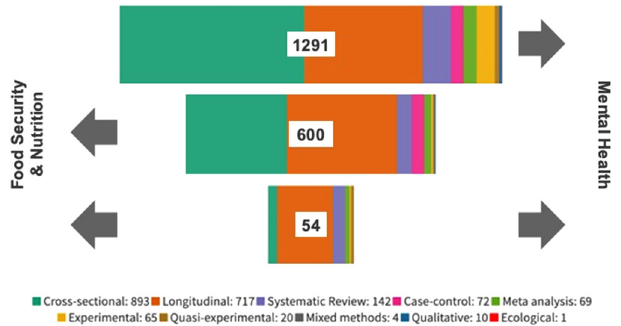
Fig.4|Directionofhypothesisinincludedstudies,segregatedbystudydesign. Thetoppanelisthenumberofstudieswithfoodsecurityandnutrition(FSN)asthe hypothesized exposure and mental health as the studied outcome. The middle panel is the number of studies with mental health as the exposure and FSN as the outcome, and the bottom panel is the number of studies where both hypotheses were